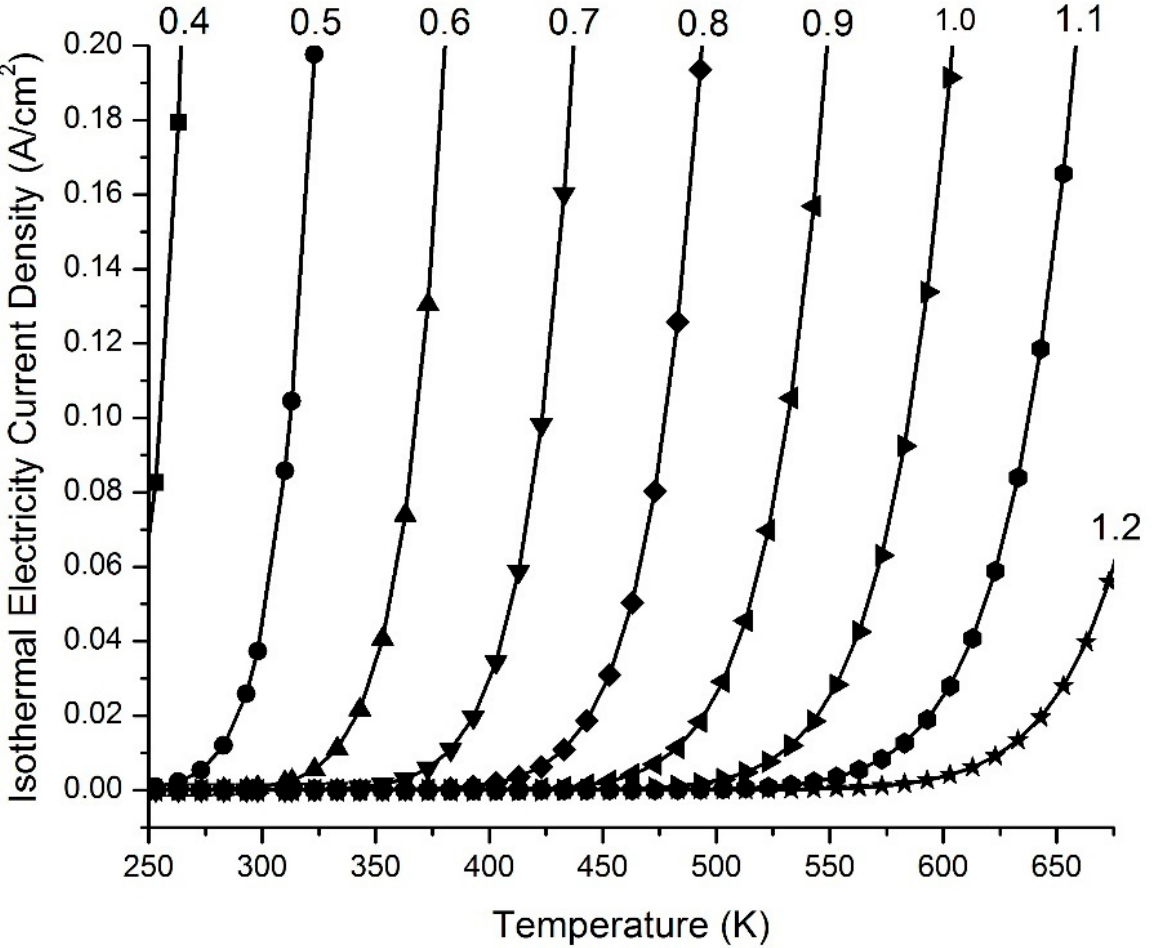
Figure 10. Presents “the computed isothermal electricity current density (A/cm 2 ) curves at an output voltage V(c) of 3.00 V as a function of operating environmental temperature T for a series of emitters with a low work function of 0.4, 0.5, 0.6, 0.7, 0.8, 0.9, 1.0, 1.1, or 1.2 eV; each of these emitters is grounded and paired with a high work function (4.56 eV)